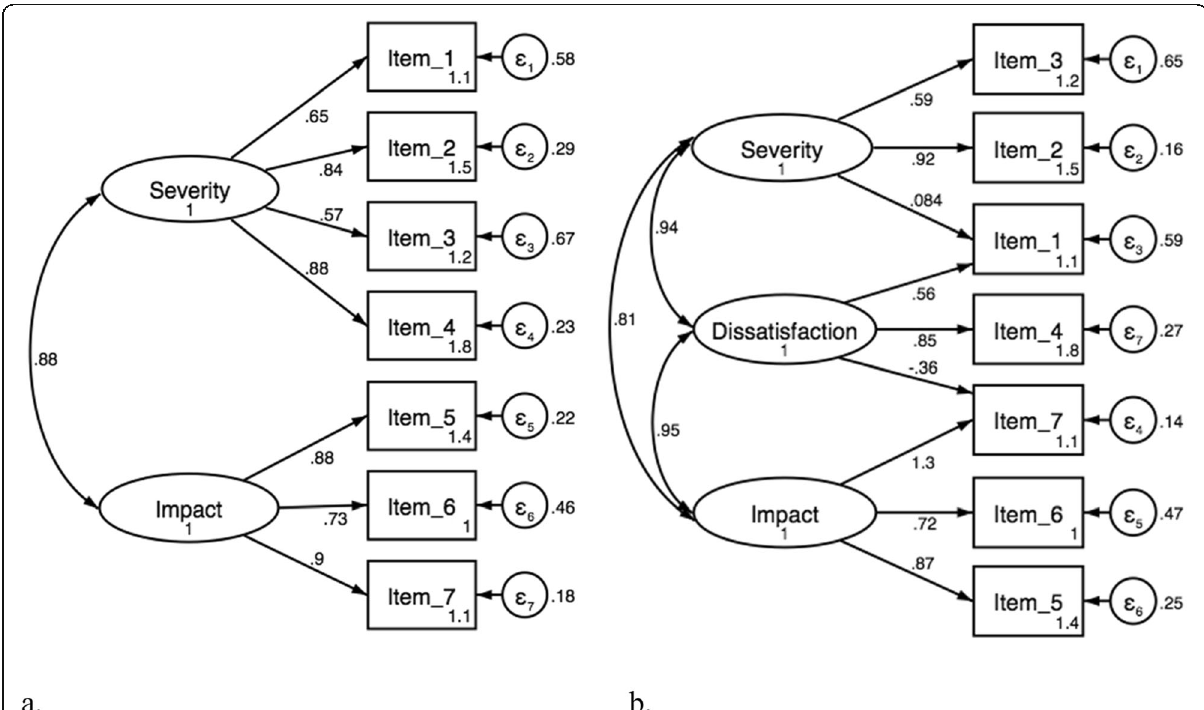
Fig. 1 Showing the two ( a ., model 2) and three ( b ., model 4) factor models of the Insomnia Severity Index Danish version with estimated factor loadings, correlation between the factors, and the residual standard errors